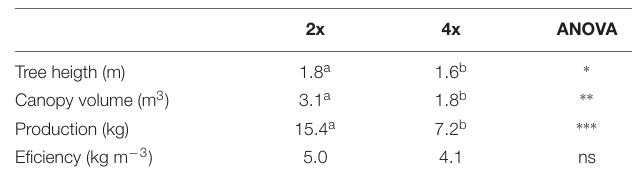
TABLE 6 | Characteristics of 6-year old VL orange trees grafted onto the 2x and 4x CC rootstocks grown under field conditions (Experiment 3).